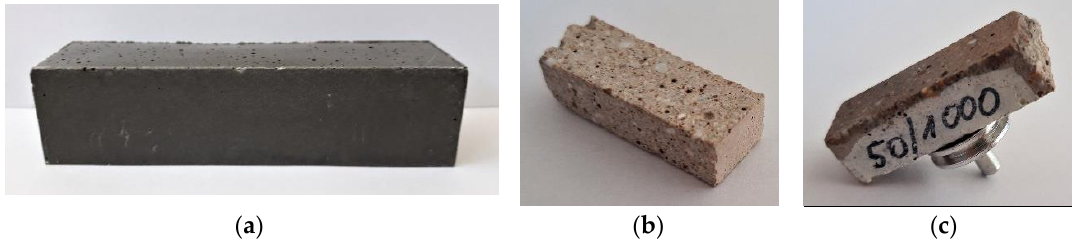
Figure 1. Samples for testing: ( a ) mortar beam 40 × 40 × 160 mm 3 ; ( b ) sample for MIP test ( c ) sample for microscopic observations.